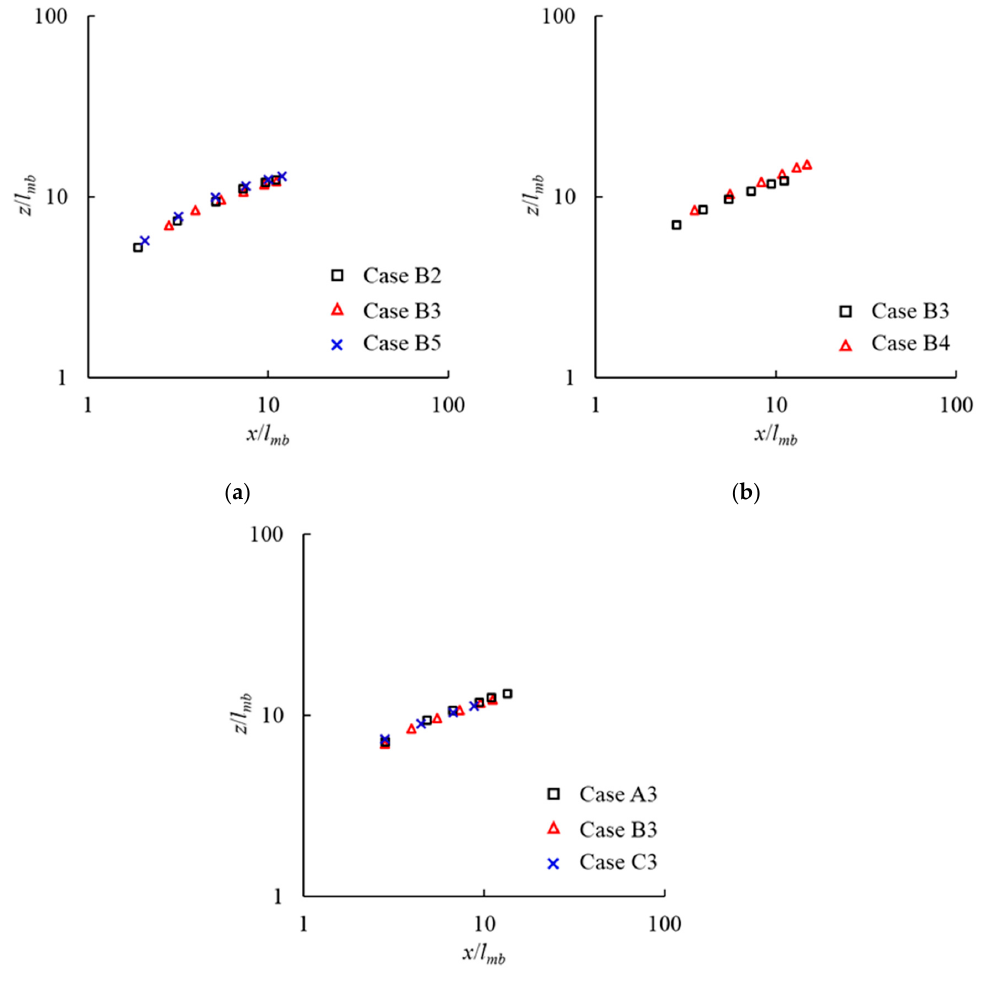
Figure 11. Effects of dimensionless parameters on the trajectories of twin buoyant jets in the wave and current environment when the length scale l mb is considered: ( a ) effect of St ; ( b ) effect of R wc ; ( c ) effect of R jc .